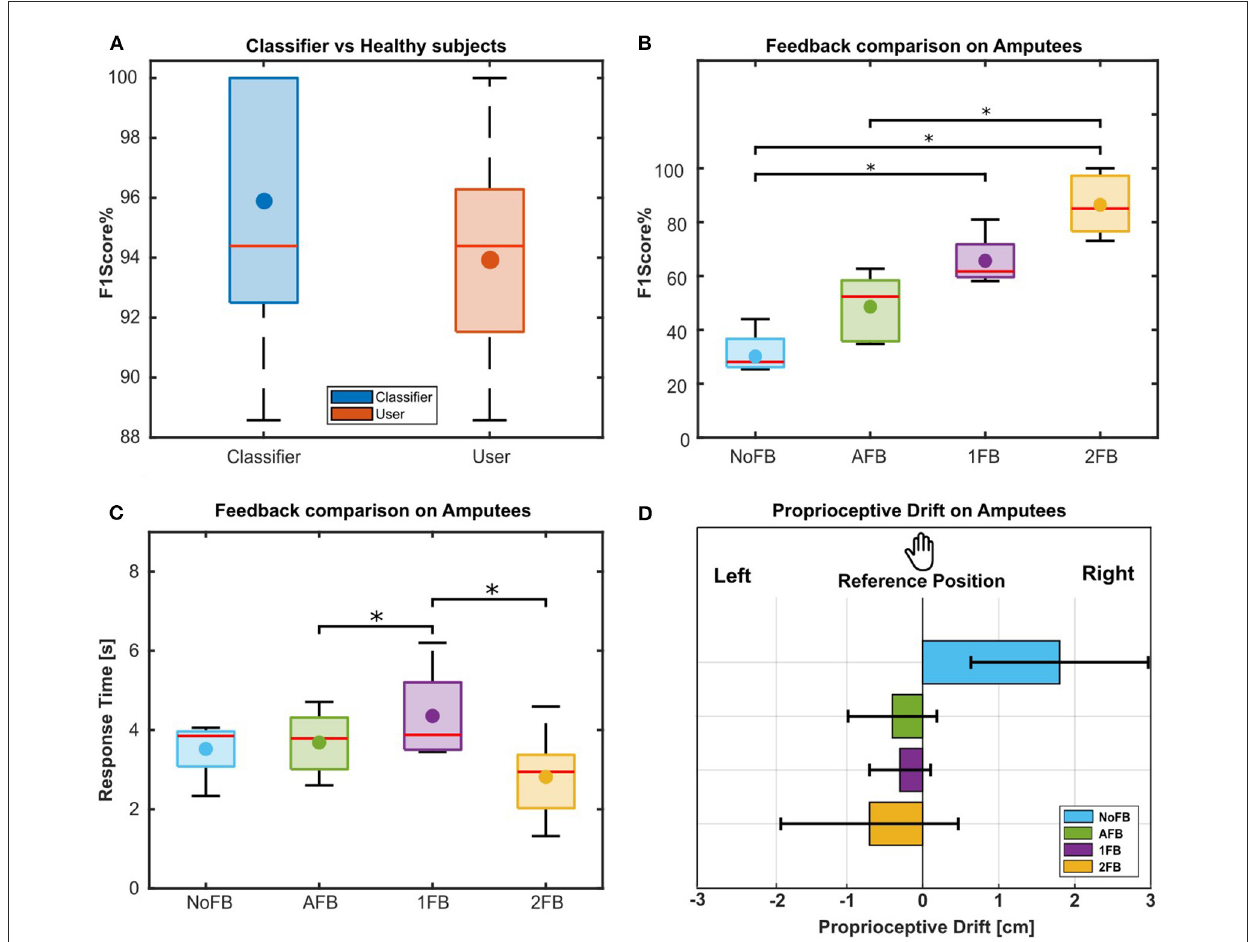
FIGURE5 (A) F1Scores results of classifier with respect to able-bodied subjects. First, the F1Score of the classifier is calculated (blue box). Then, the F1Score of 18 able-bodied subjects is evaluated, based on the answer of classifier, in recognizing the objects’ stiffness while receiving the 2FB condition (red box). A comparison between classifier’s and subjects’ F1Score was assessed and no significant difference was found between the two populations. (B) F1Scores results for amputees. F1Score obtained by amputees for each feedback condition. The Box chart shows the comparison between the distributions of the F1Scores obtained in each condition. The statistically significant difference is indicated by “ * ” ( p < 0.05). (C) Response time results for amputees. Response time obtained by amputees for each experimental condition. The Box chart shows the comparison between the distributions of the response time obtained in each condition. The statistically significant difference is indicated by “ * ” ( p < 0.05). (D) Proprioceptive drift of amputees for the different feedback conditions as a quantitative embodiment measure. The barplot shows the mean and standard deviation of the drift over amputees for each condition, the left direction is toward Hannes hand, and the right direction indicates a movement on the opposite side of Hannes hand. Deviations toward the prosthesis were considered an effect of the embodiment process.